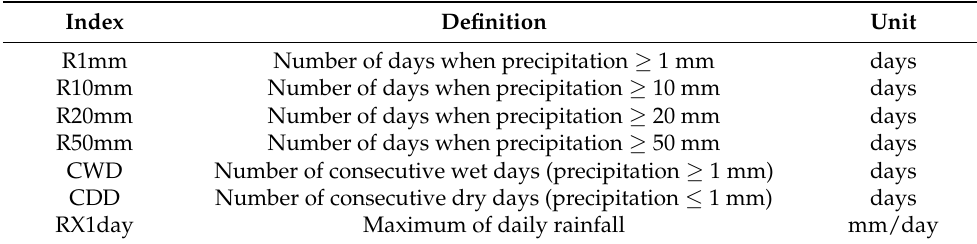
Table 4. List of the selected extreme indices from ETCCDI used in this